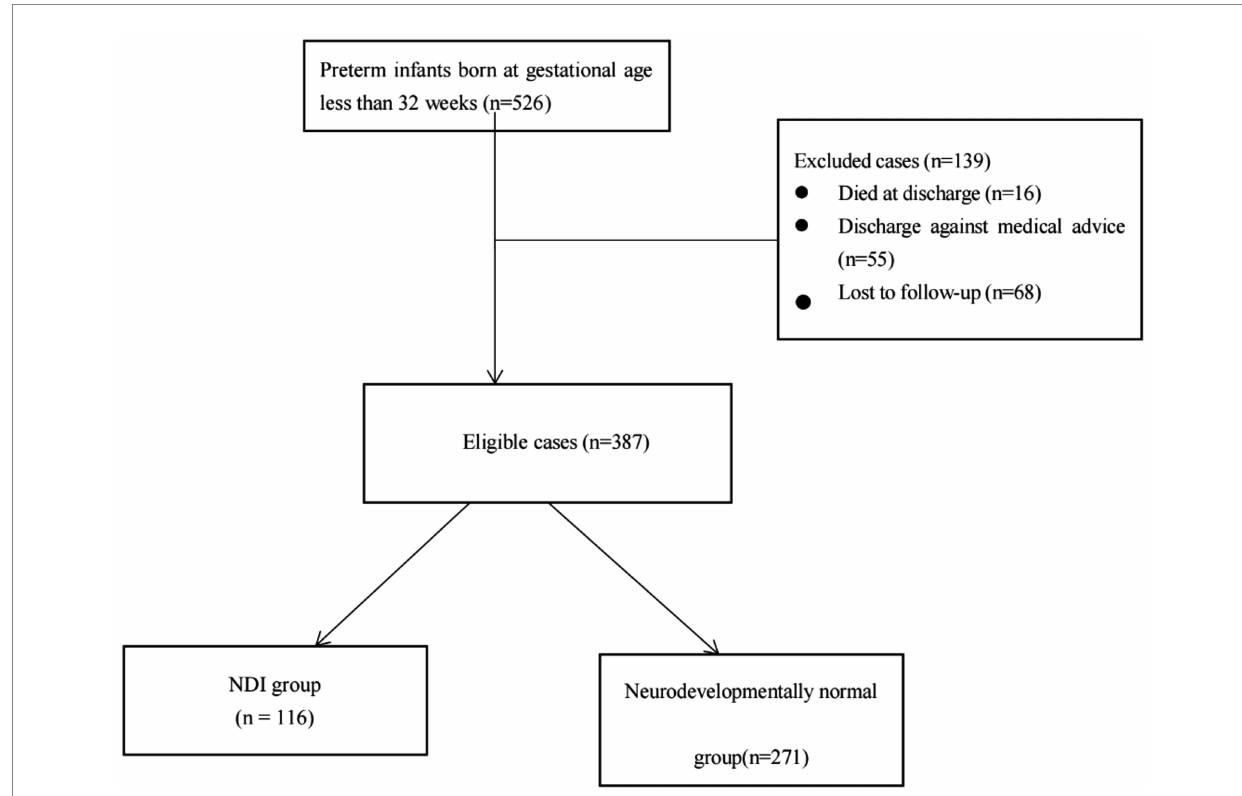
FIGURE 1 Flowchart of participants through each stage of the study. NDI: Neurodevelopmental